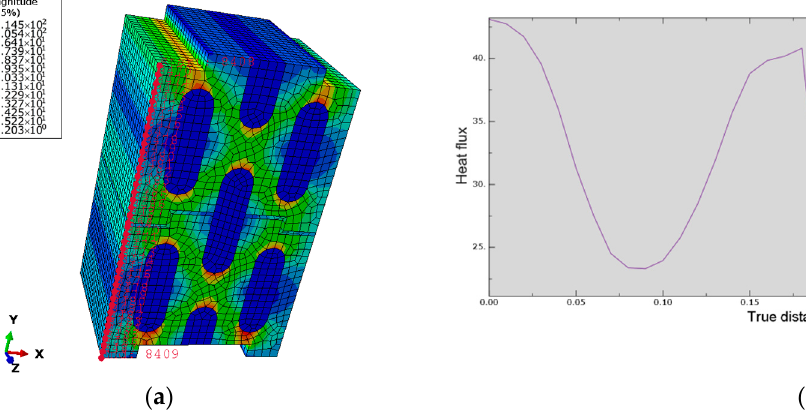
Table 4. Heat transfer coefficient between the model and